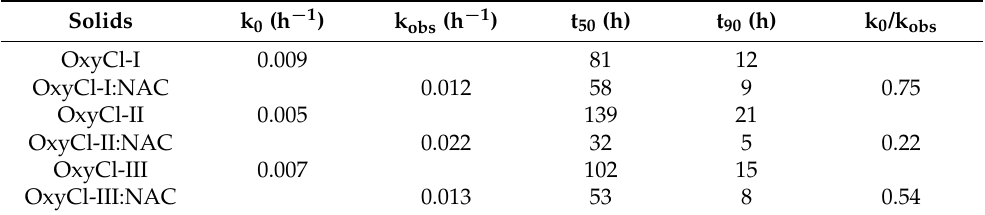
Table 5. Kinetic parameters of the degradation process in PBS at 25.0 ± 0.1 ◦ C.